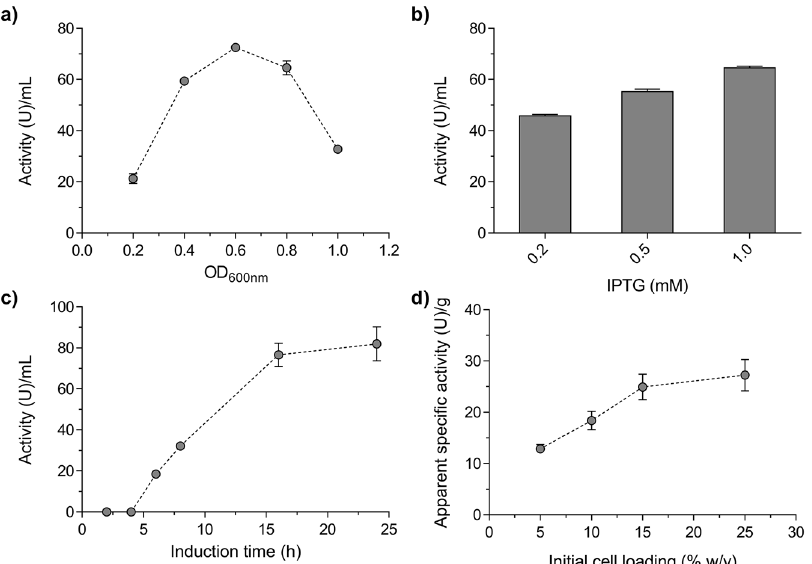
Figure 1. Optimization of Mr- α Glu activity in E. coli and alginate beads preparation. The maximum hydrolytic activity of the bacteria cells expressing the protein Mr- α Glu was determined at different: ( a ) optical cell densities (OD600 units) for 16 h induction with 1 mM IPTG, ( b ) IPTG concentration added to E. coli cultures (~0.6 OD600 units) incubated for 16 h and ( c ) induction times of E. coli cultures (1 mM IPTG and ~0.6 OD600 units). ( d ) Evaluation of the biocatalyst activity in relation to the cells concentration used in the alginate beads preparation. All bacteria cultures were incubated at 16 °C. Hydrolytic activity was determined using 100 g/L sucrose (30 °C, 20 min) by the 3,5-dinitrosalicylic acid (DNS) method. Error bars represent the standard deviations from three independent analysis.